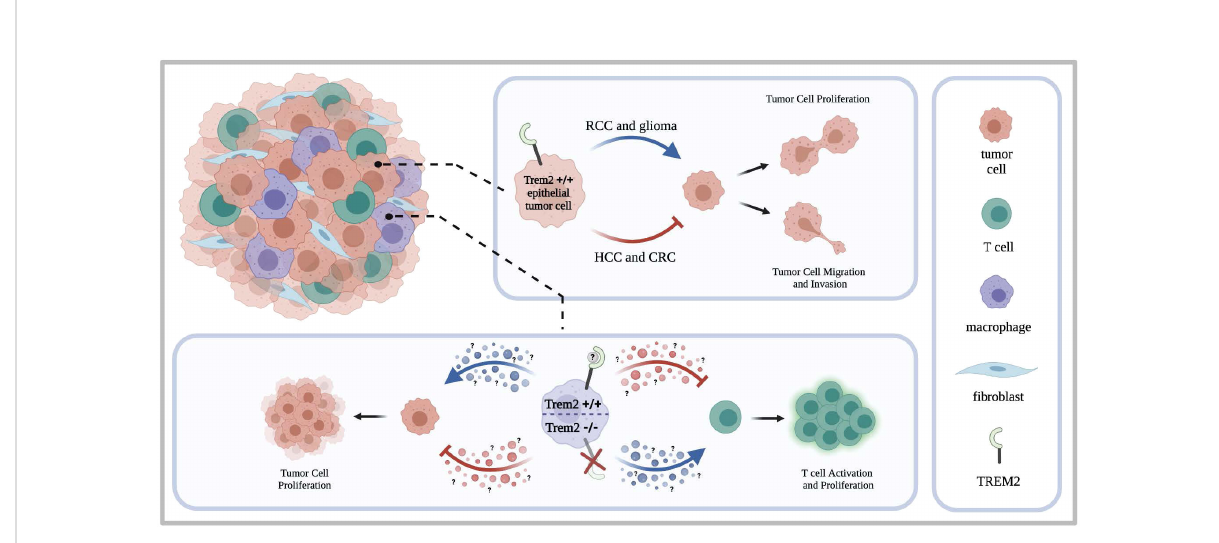
FIGURE 1 TREM2 in heterogeneous tumors. Tumors are composed of a heterogeneous makeup of cells including the tumor cells, tumor associated macrophages, T cells, and tumor associated fi bro blasts. Studies have shown that TREM2 can be expressed by both epithelial tumor cells and in fi ltrating immune cells such as macrophages. When expressed by the epithelial tumor cells, studies indicate that TREM2 supports oncogenic activity in renal cell carcinoma and glioma but contributes to tumor suppressing activity in renal cell carcinoma. Thus, contributing to oncogenic or tumor suppressing activity, TREM2 can enhance or inhibit tumor cell proliferation and tumor cell migration and invasion. When expressed by in fi ltrating immune cells such as macrophages, the literature indicates that TREM2 expressing immune cells contribute to creating an immunosuppressive environment by inhibiting T cell activation and proliferation. Consequently, tumor cell proliferation is then enhanced. When TREM2 is knocked out on the tumor in fi ltrating immune cells, increased T cell activation and proliferation is observed accompanied by a decrease in tumor